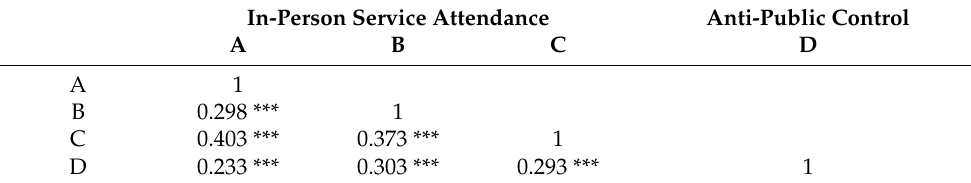
Table 11. Correlations among major dependent variables (N = 1000).